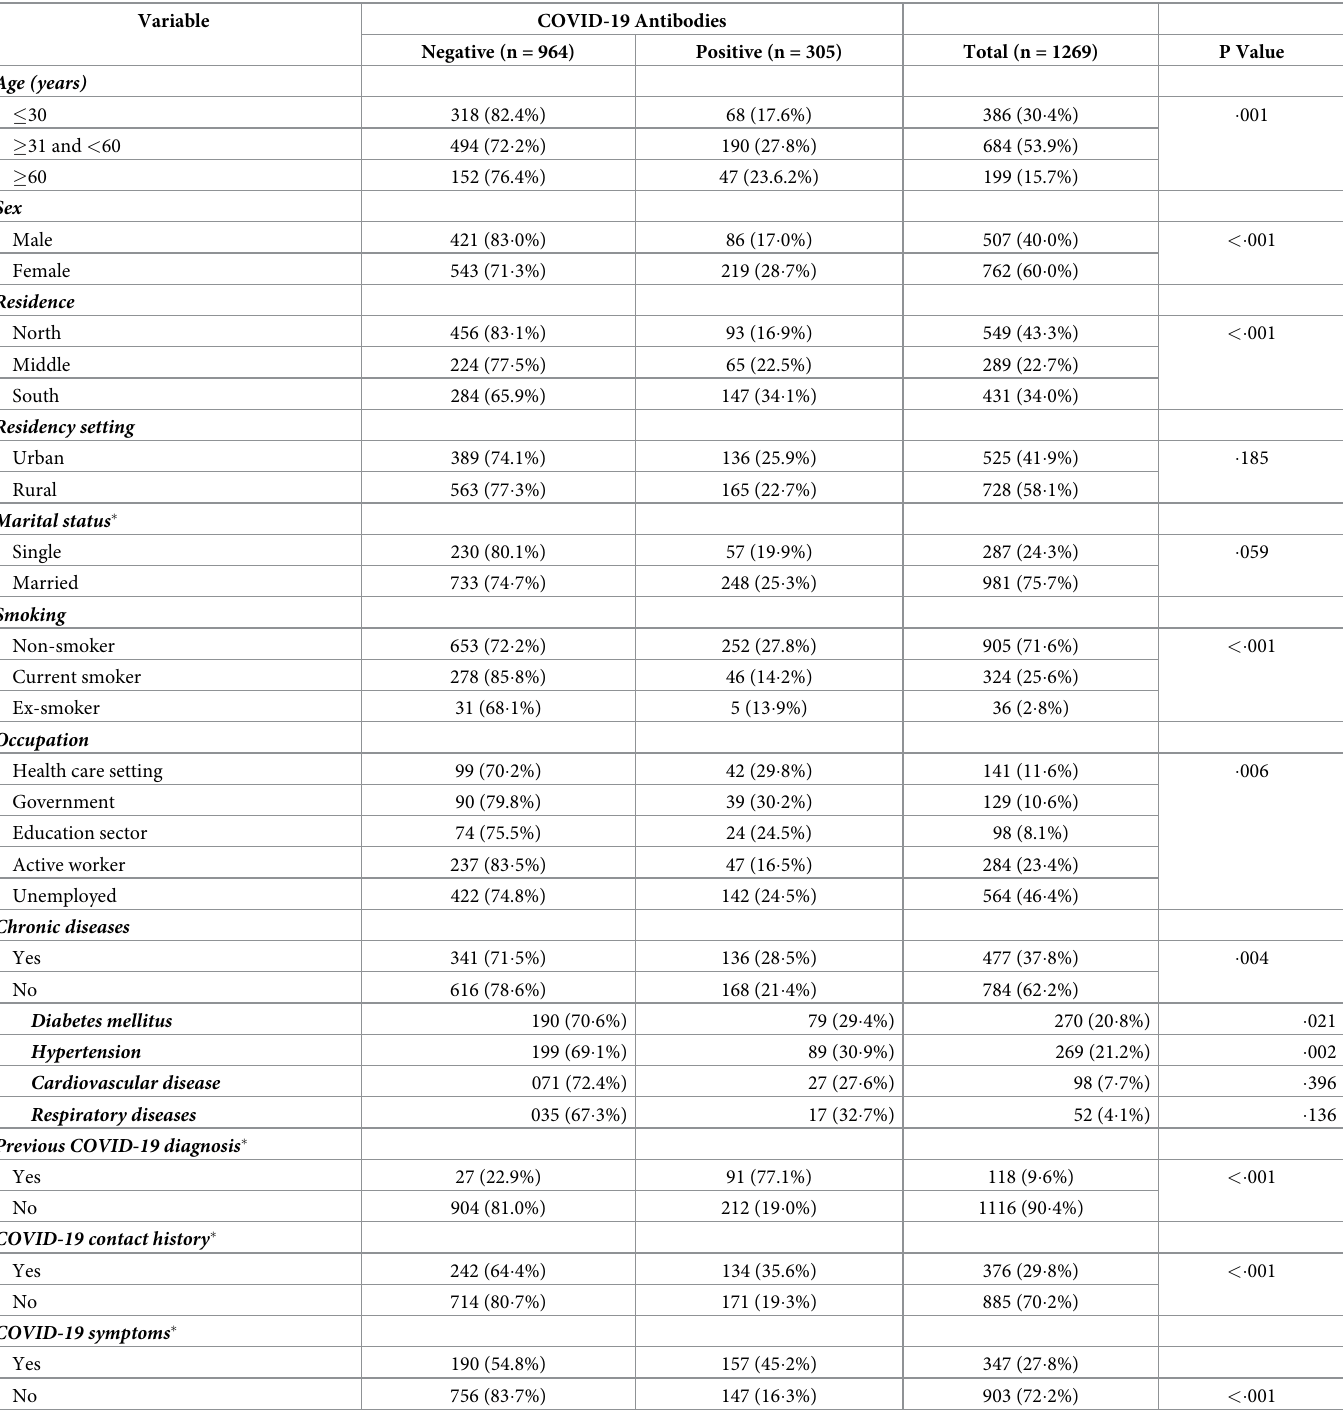
Table 1. Background characteristics according to SARS-CoV-2 seroprevalence (n =